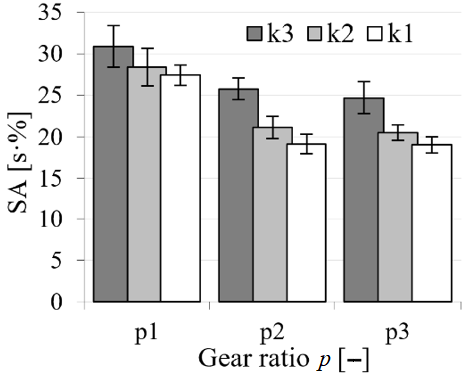
Figure 8. Average values of the area under the diagram (SA) for measurement tests s2, k1-3 and p1-3 for the muscle: extensor carpi radialis longus (D); error bars are ± standard deviation.